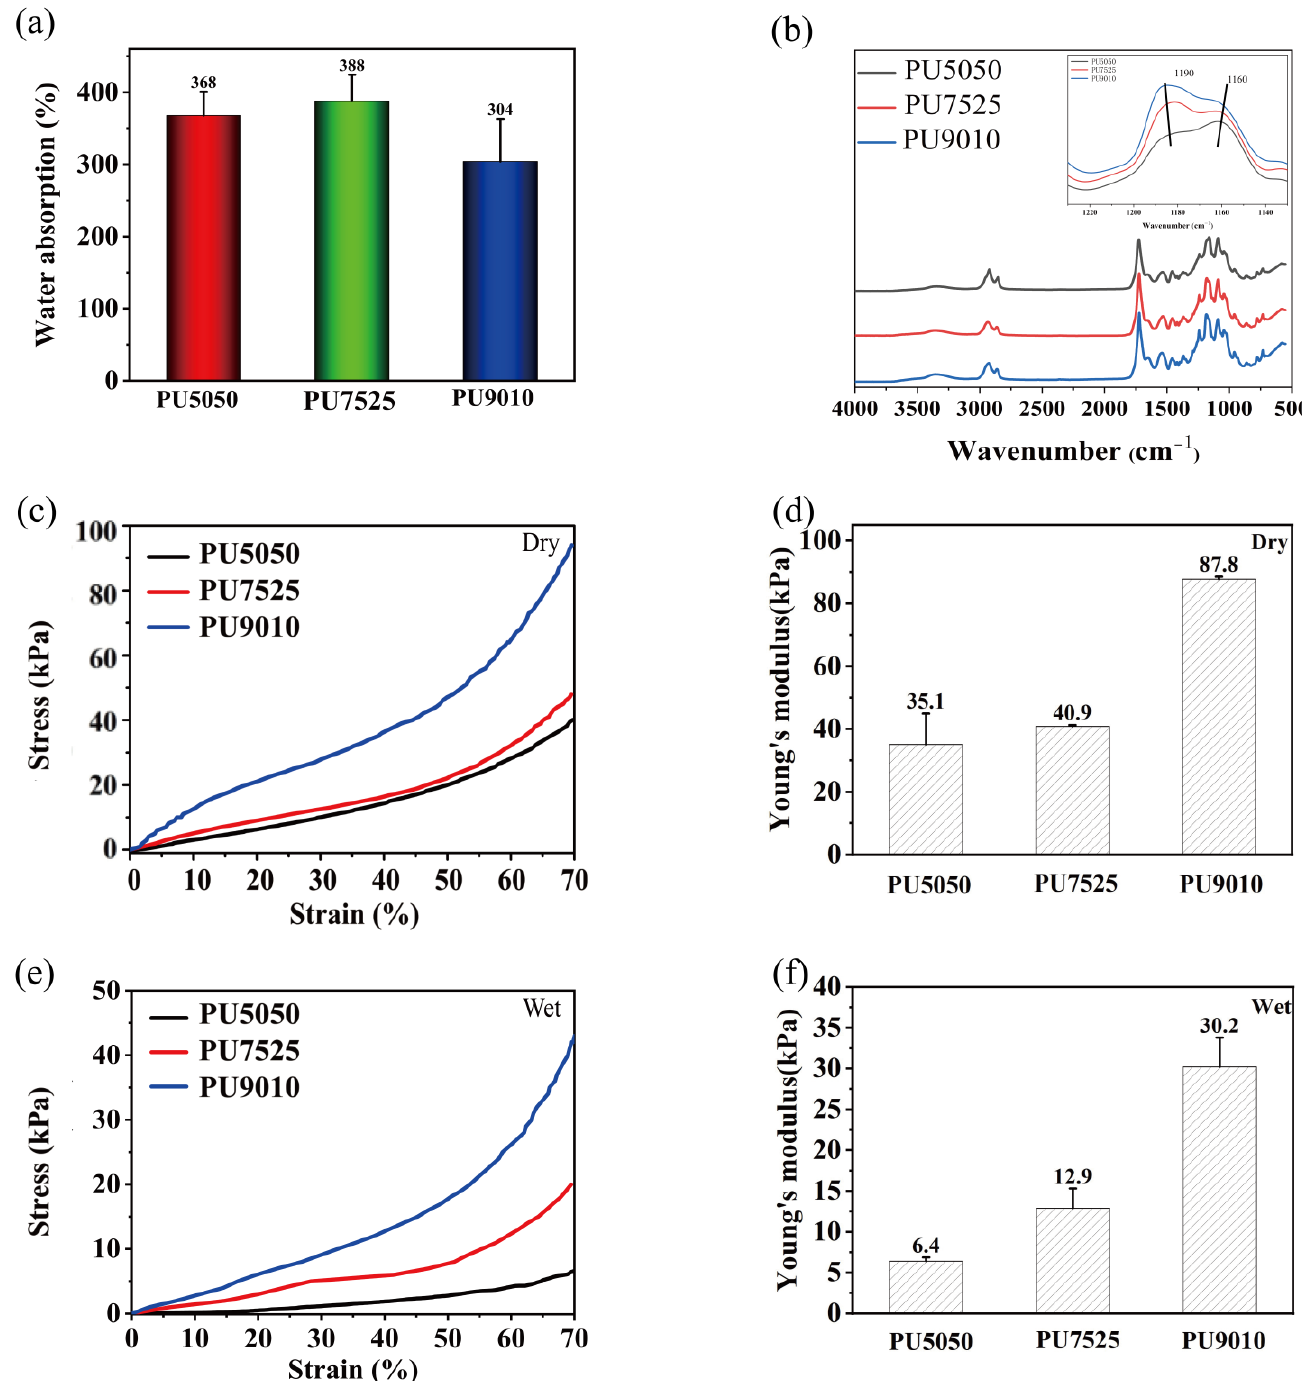
Figure 1. ( a ) Water absorption of PU5050, PU7525 and PU9010 scaffolds. ( b ) ATR−FTIR spectra of PU5050, PU7525 and PU9010. ( c ) Compression curve of PU5050, PU7525 and PU9010 scaffolds in dry state. ( d ) Young’s modulus of PU5050, PU7525 and PU9010 scaffolds in the dry state. ( e ) Compression curve of PU5050, PU7525 and PU9010 scaffolds in the wet state. ( f ) Young’s modulus of PU5050, PU7525 and PU9010 scaffolds in the wet state. The data are shown as mean ± SD (n ≥ 3).